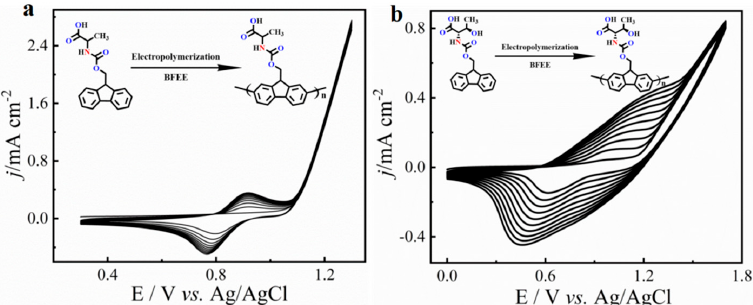
Figure 2. Multicycle CVs of monomer Fmoc-Ala-OH ( a ) and Fmoc-Thr-OH ( b ) in the BFEE system. Potential scan rate of 100 mV s − 1 .